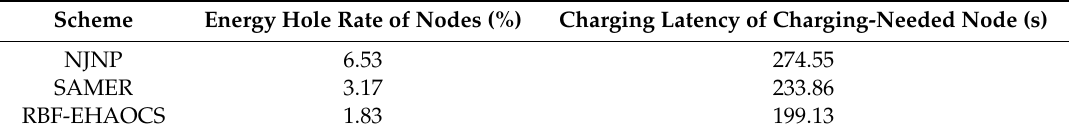
Table 2. The performance under di ff erent